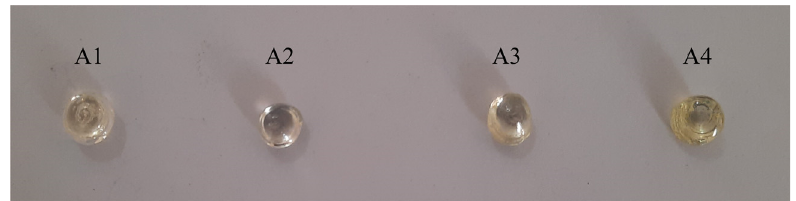
Figure 1: Picture of prepared samples: A1, A2, A3, A4.